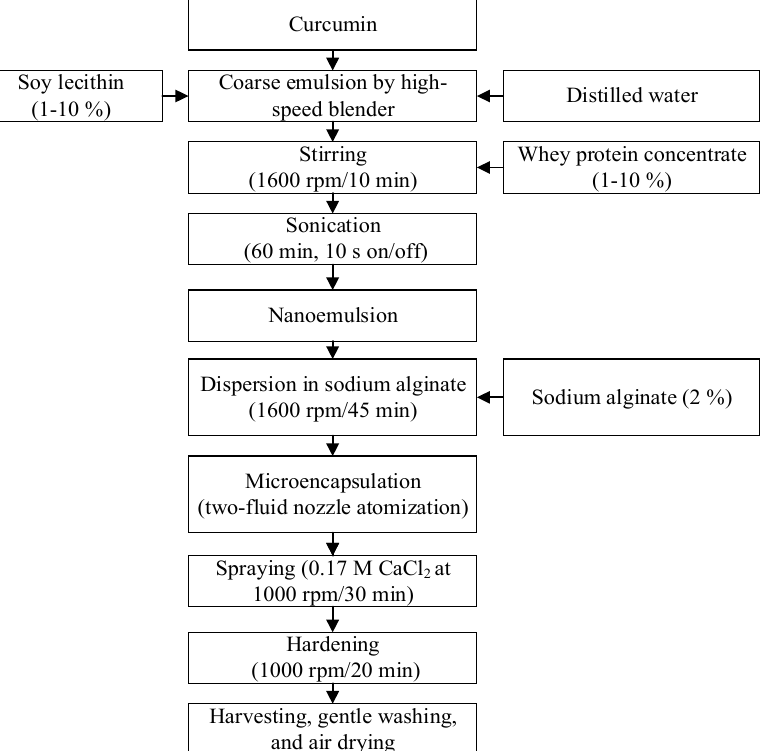
Figure 1. Preparation of CHBs by ionotropic gelation method. CHBs, curcumin hydrogel